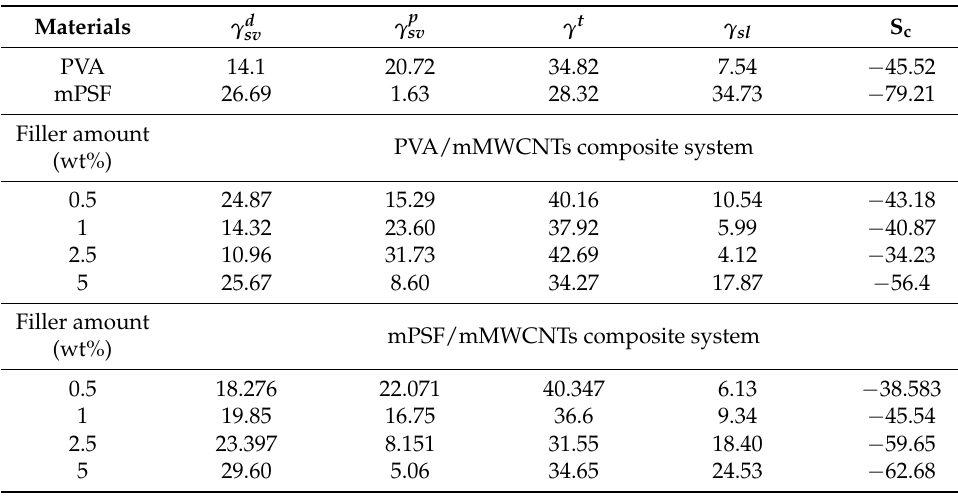
Table 3. Surface free energy and their components (mN/m) of all pure materials and their corre- sponding composites